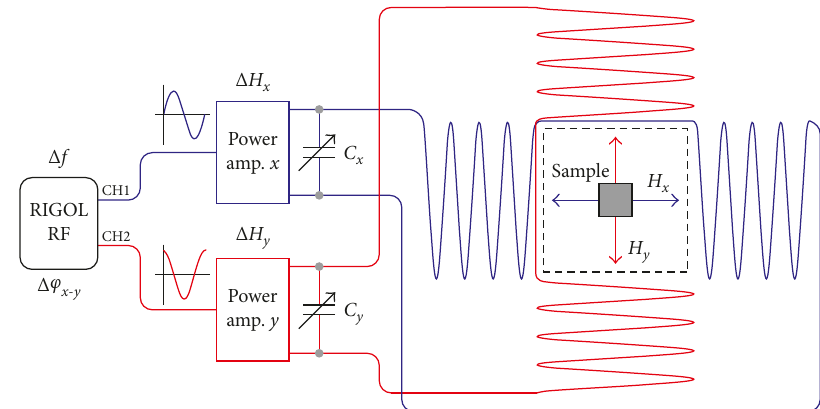
Figure 1: Arrangement of the supply coils of the measurement system and the position of the sample in the center.